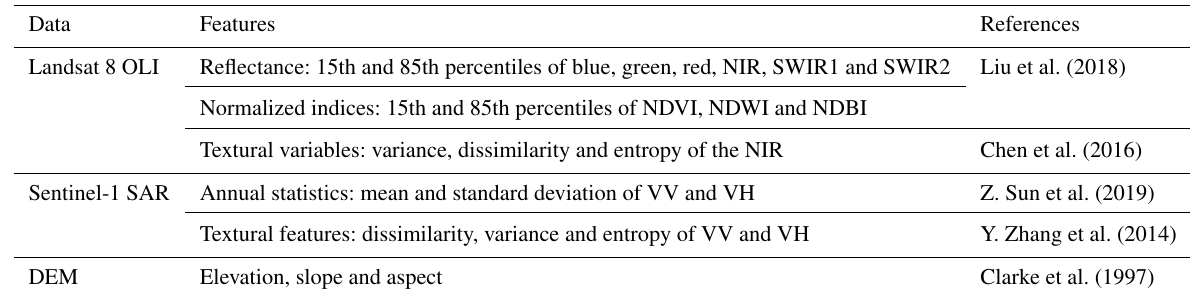
Table 1. Training features for global impervious surface mapping.